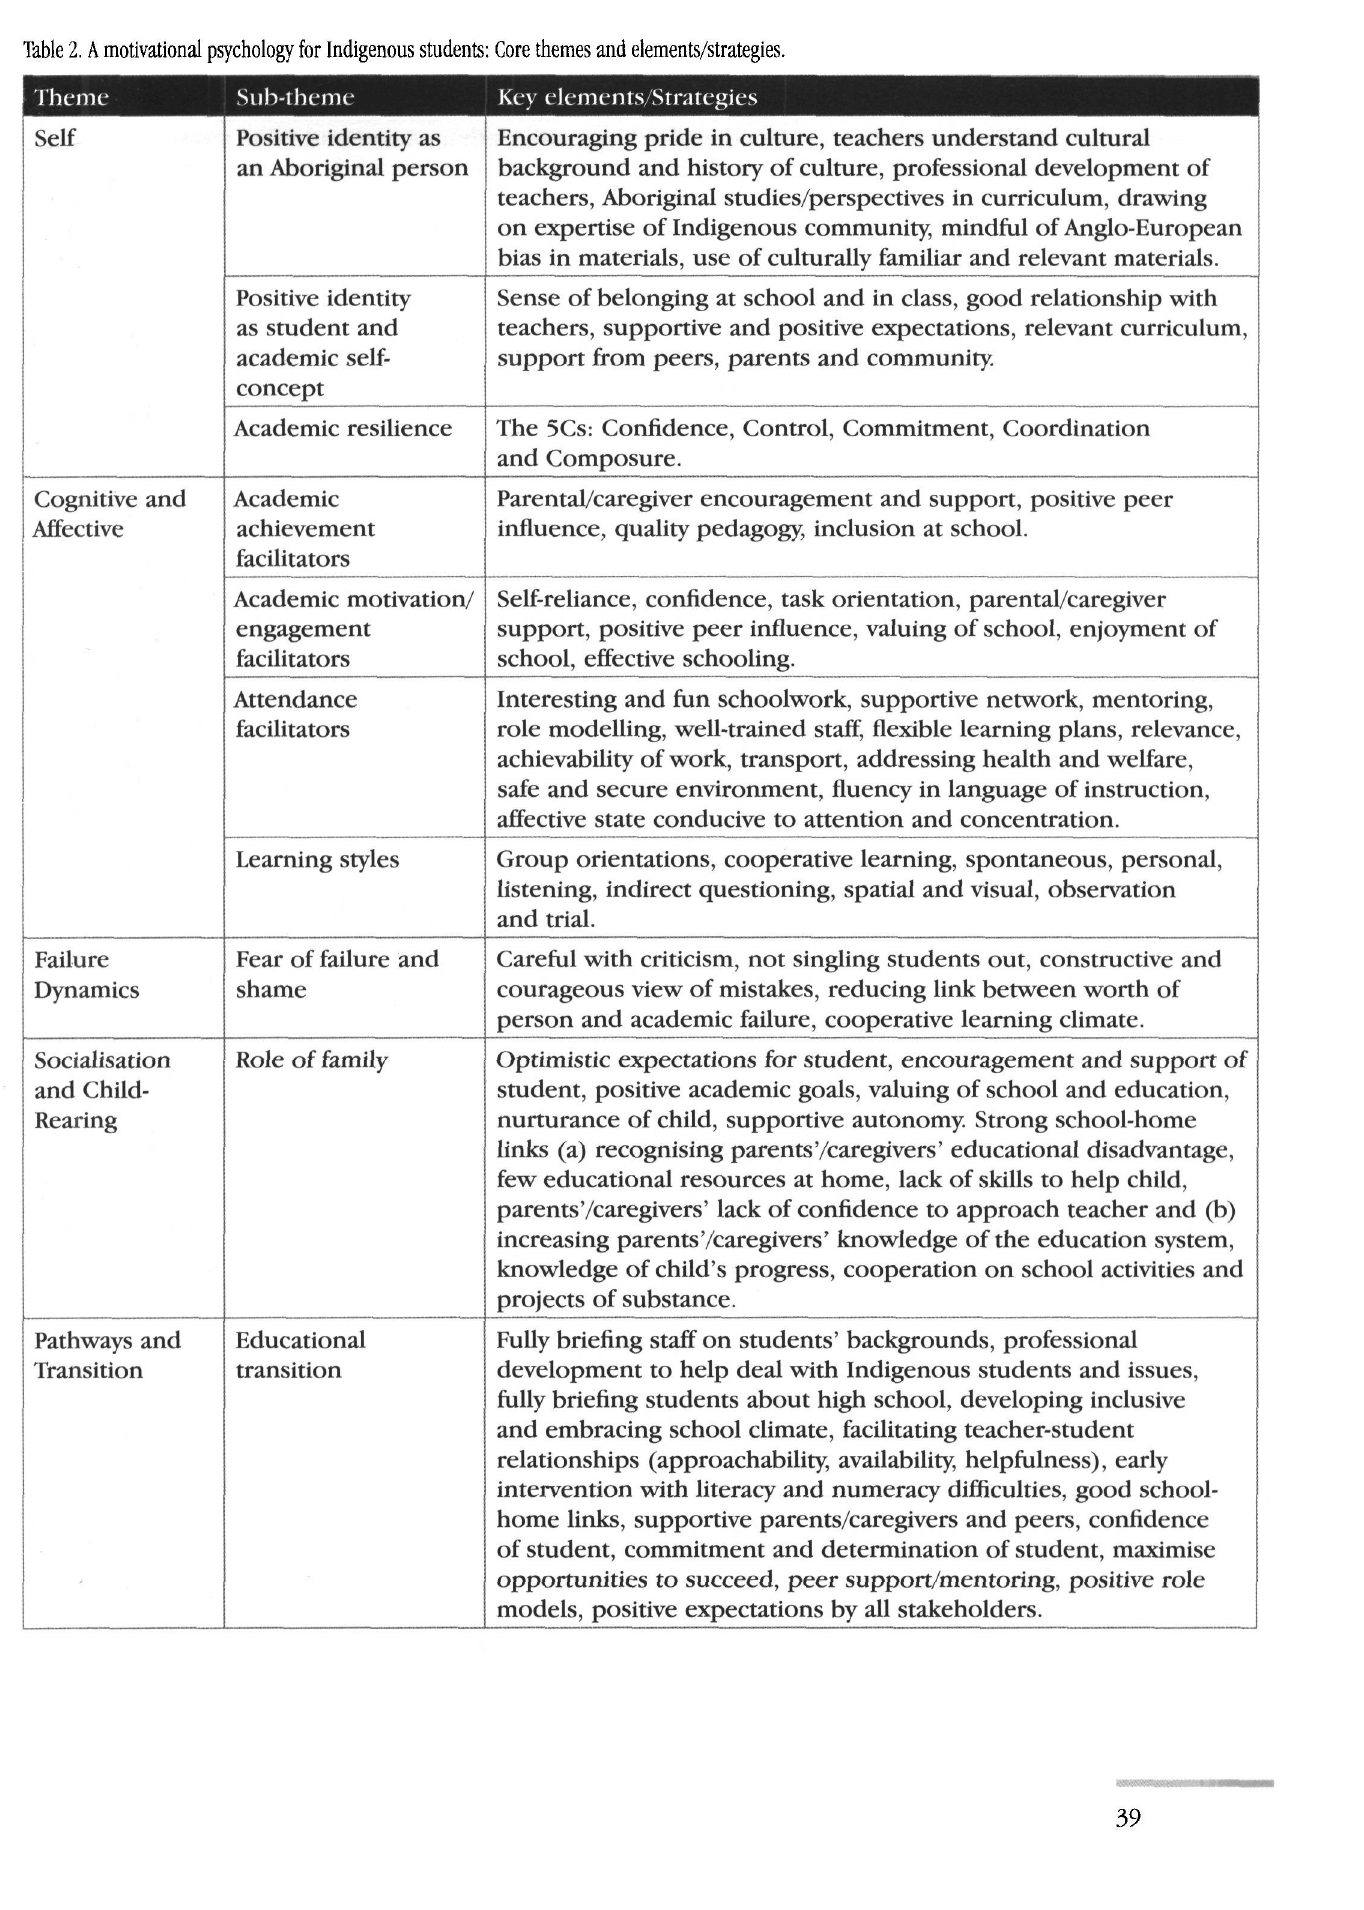
Table 2. A motivational psychology for Indigenous students: Core themes and elements/strategies. Theme Sub-theme Key